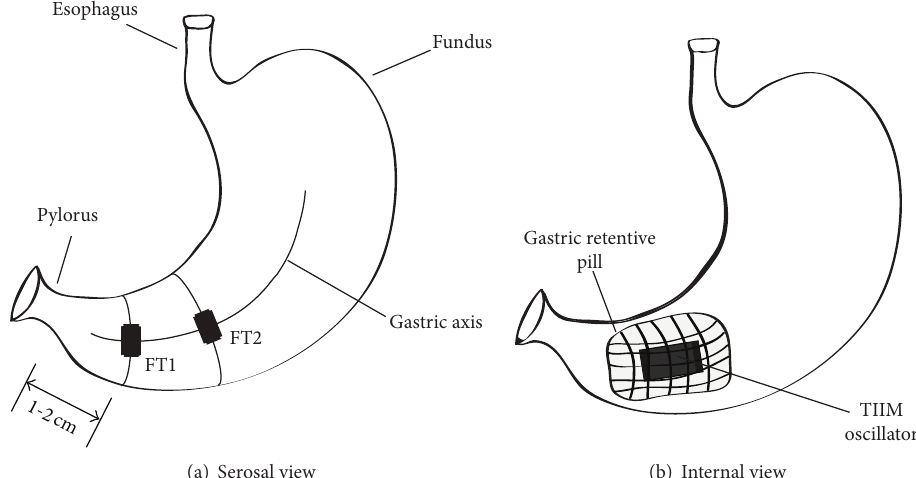
Figure 2: Position of the force transducers sutured to the serosa of the stomach (a) and the intraluminal position of the expanded gastric- retentive pill carrying the TIIM oscillator